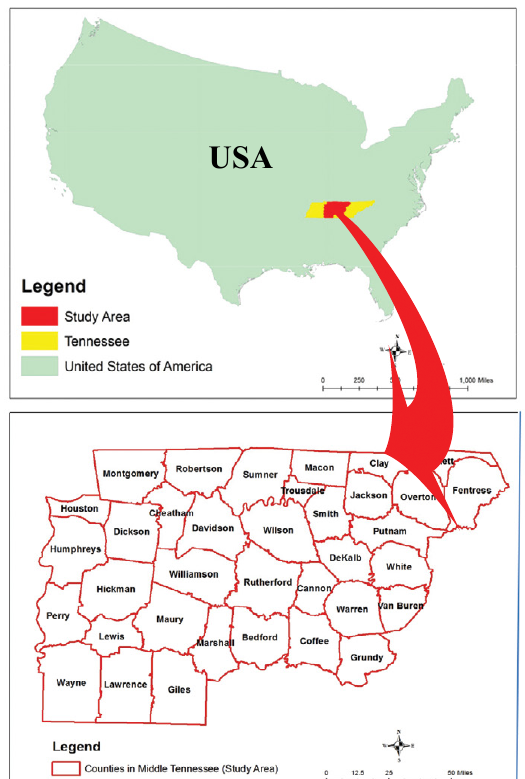
Fig. 1: Geographic location of the study area in middle Tennessee, southeastern parts of the United States of